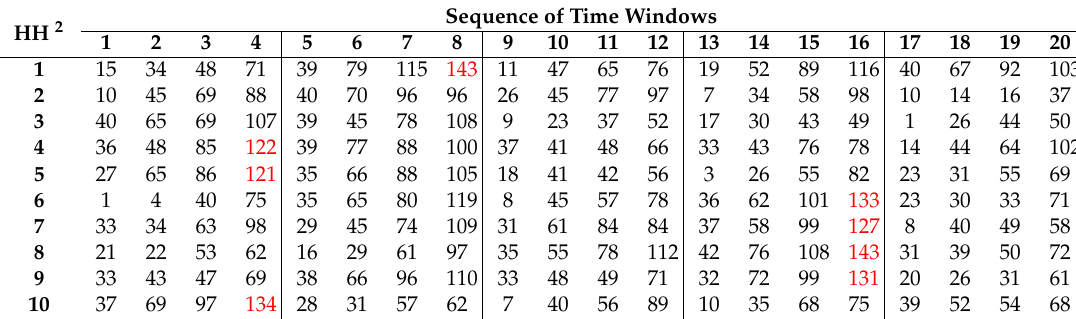
Table 3. The cumulative volume of generated waste in households 1